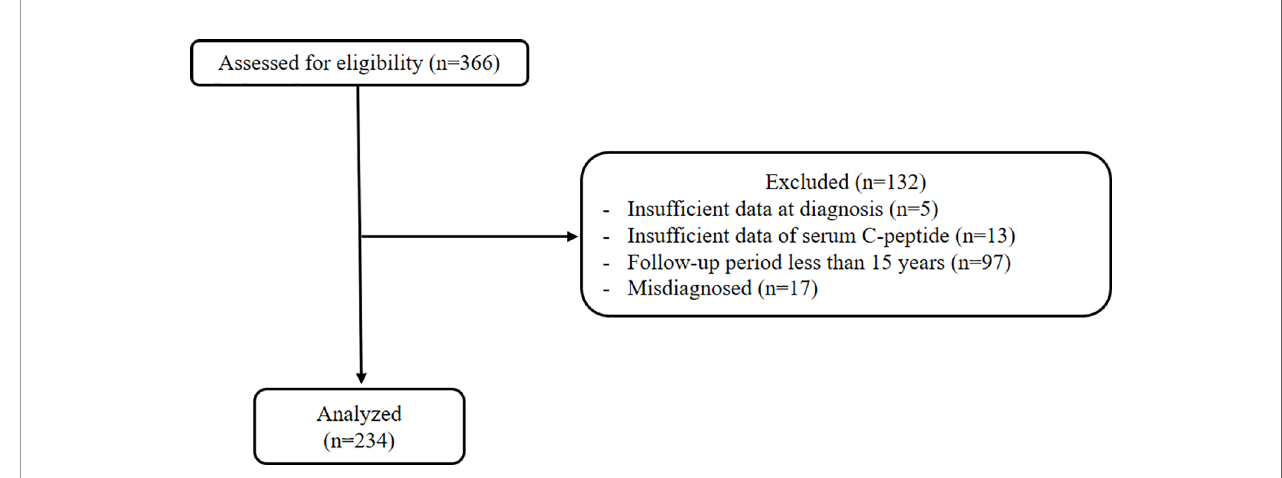
FIGURE 1 | Flow chart for patient selection.